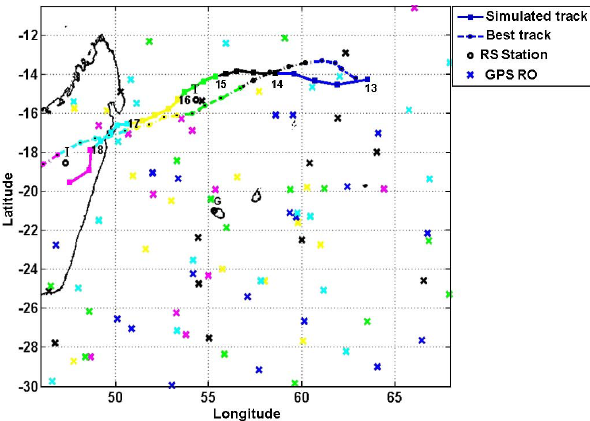
Fig. 2. TC Ivan best track data (RSMC La Réunion, dashed line) and cyclone track data obtained by simulation (Meso-NH, solid line). Crosses indicate locations of GPS RO soundings and black circles correspond to locations of meteorological radio sounding (RS) sta- tions (G: Gillot, I: Ivato, T: Tromelin). Colours of crosses and seg- ments of tracks indicate the day (13 February – navy blue; 14 Febru- ary – black; 15 February – green; 16 February – yellow; 17 February – light blue; and 18 February –